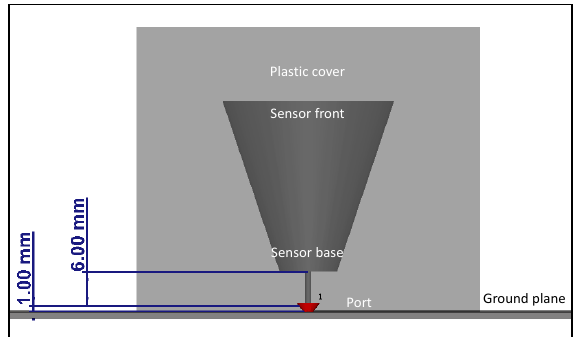
Figure 2. Design of the drain valve sensor.